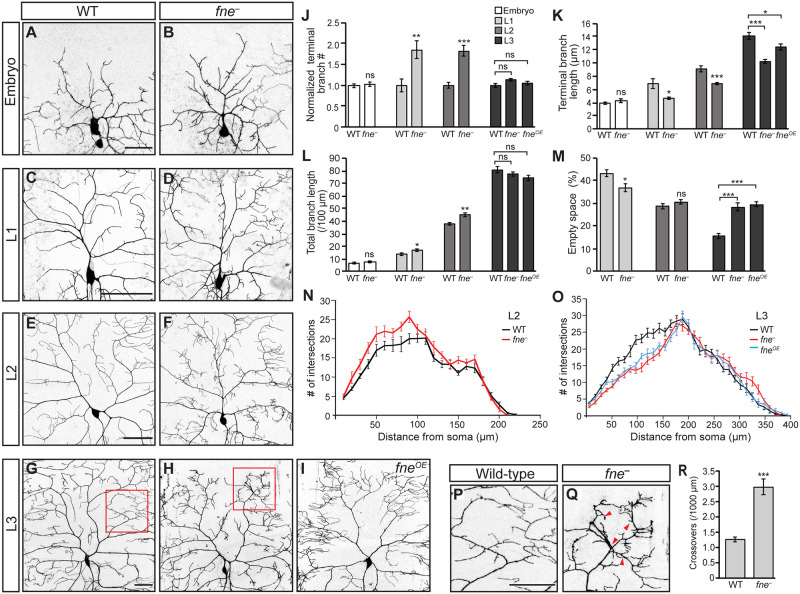
Fne is required beginning in L1 for the space-filling arborization of class IV da neurons.(A-I) Confocal z-series projections of representative class IV da neurons from wild-type (WT; A, C, E, G), fne−(B, D, F, H), or fneOE (I) larvae at the end of embryogenesis (A, B), L1 (C, D), L2 (E, F), and L3 (G–I). For fneOE, ppk-GAL4 was used to drive expression of UAS-fne. For all genotypes, ppk-GAL4 was used to express UAS-CD4-tdGFP to mark the neurons. (J) Quantification of terminal branch number. The values for the fne− and fneOE neurons are normalized to the number of terminal branches in wild-type neurons at each time point. (K) Quantification of terminal branch length. (L) Quantification of total dendrite length. (M) Quantification of the amount of empty space within the arbor. (N, O) Sholl analysis of the indicated genotypes at L2 (N) and L3 (O). (P, Q) Magnified view of the areas outlined in red in G and H, with red arrows indicating points of dendrite crossing over events. (R) Quantification of all crossover events in WT and fne− neurons normalized to branch length. For (J-O, R) n = 10 neurons (WT, embryo), 10 neurons (fne–, embryo), 6 neurons (WT, L1), 6 neurons (fne–, L1), 10 neurons (WT, L2), 11 neurons (fne–, L2), 13 neurons (WT, L3), 10 neurons (fne–, L3), 17 neurons (fneOE, L3). Two-tailed Student’s t-test was used to determine significance between WT and fne− at the embryo, L1 and L2 stages (J-M) and in (R). The one-way ANOVA with Bonferroni-Holm post hoc test (J, K, M) or the Kruskal-Wallis with Dunn’s post hoc test (L) was used to determine significance for L3. Values are mean ± s.e.m.; ns = not significant, *p<0.05, **p<0.01, ***p<0.001. Scale bars: (A) 20 μm, (B-D, P) 50 μm.